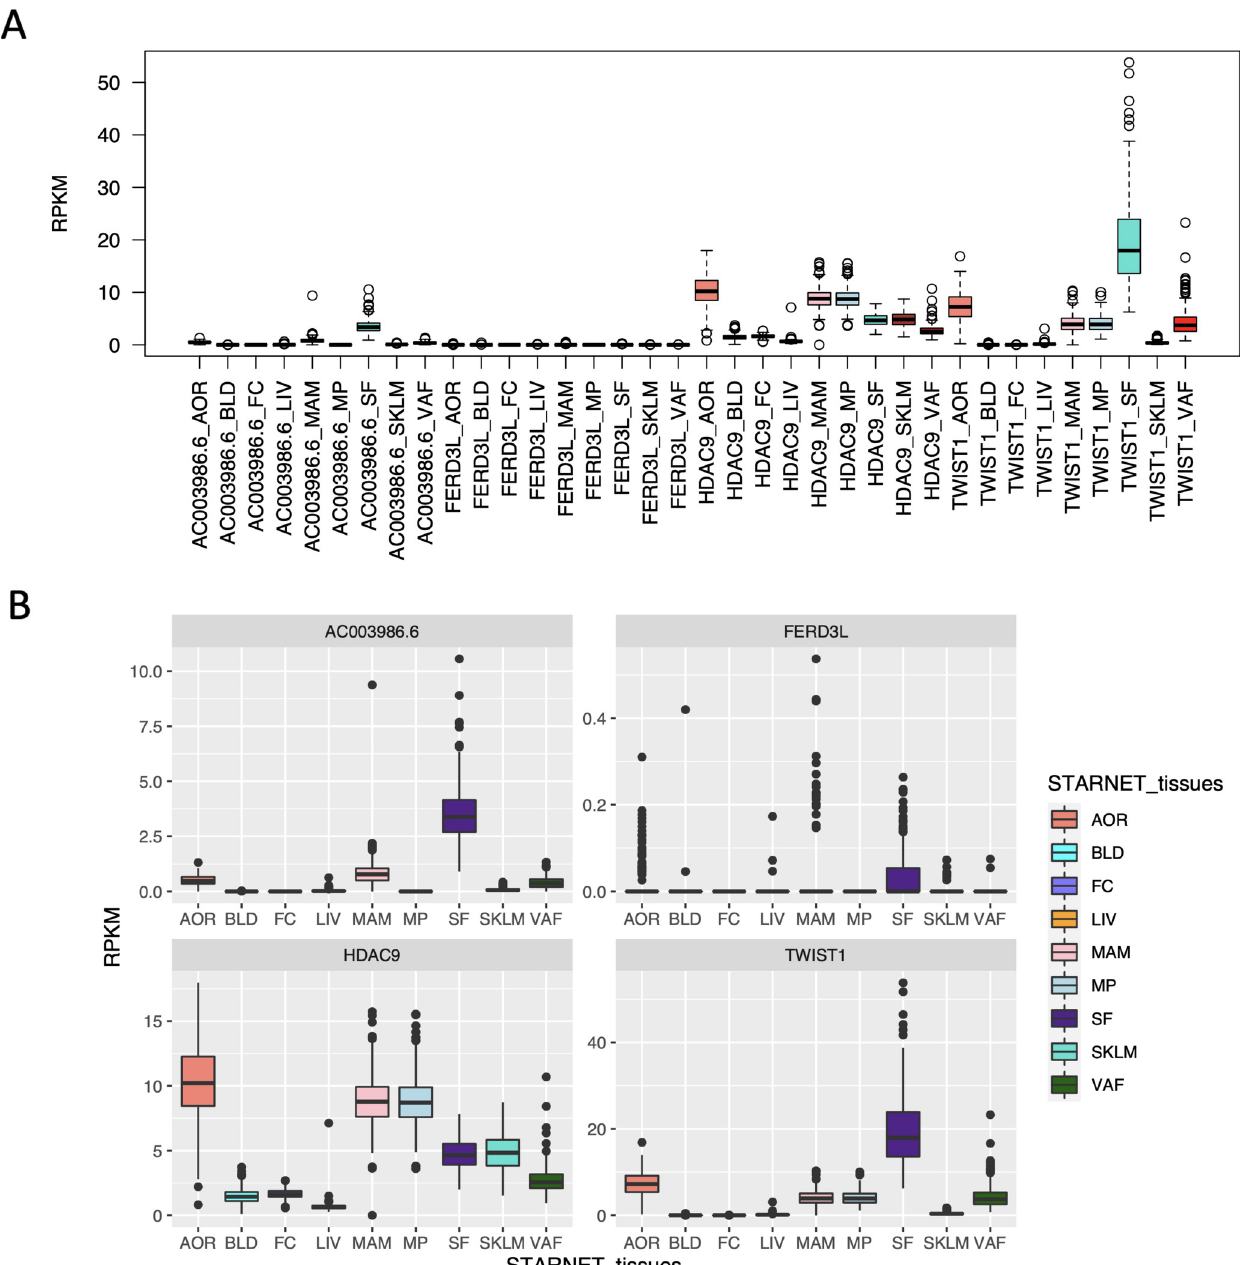
Fig 4. Gene expression levels in STARNET. (A) Gene expression levels of HDAC9 , TWIST1 , FERD3L and AC003986.6 in STARNET–which generally show higher expression levels of HDAC9 and TWIST1 across various tissue subtypes. (B) Same as A but at different scales for each gene. RPKM, Reads Per Kilobase of transcript per Million mapped